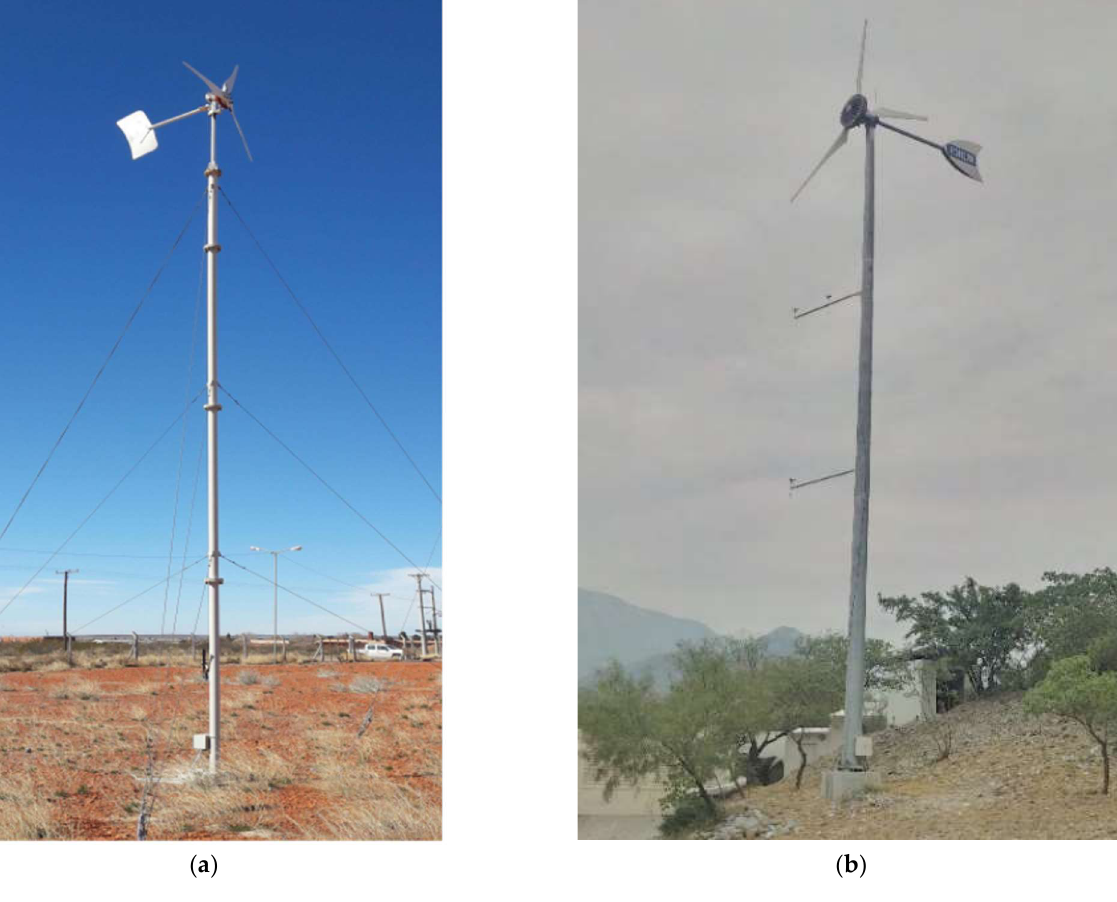
Figure 1. Small wind turbines: 1000 W Eolocal ( a ) and 5 kW Aeroluz ( b ).